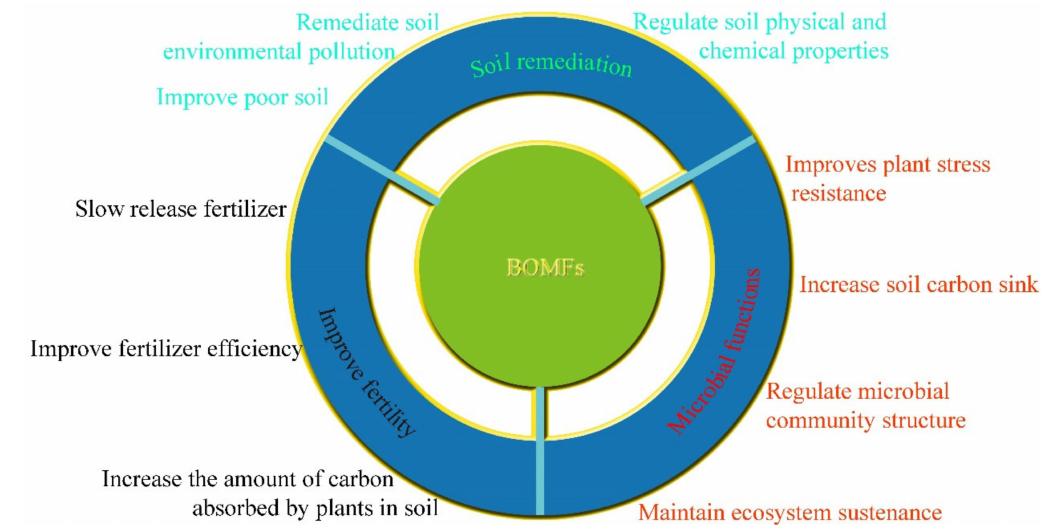
Figure 2. Ecological effect of BOMFs